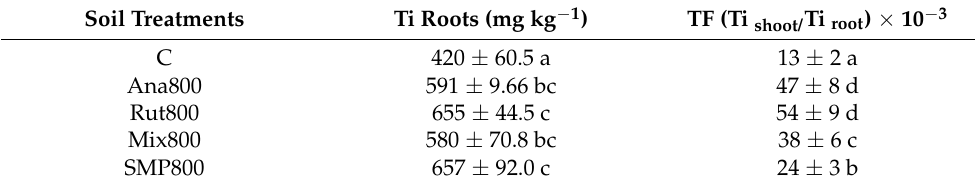
Table 2. Titanium concentration in the roots and Ti translocation factor (TF, ratio Ti shoots to roots) of P. sativum plants exposed to different soil treatments. Values are means ± sd (n = 4), different letters in the same column represent significant differences among the mean values ( p < 0.05). Soil